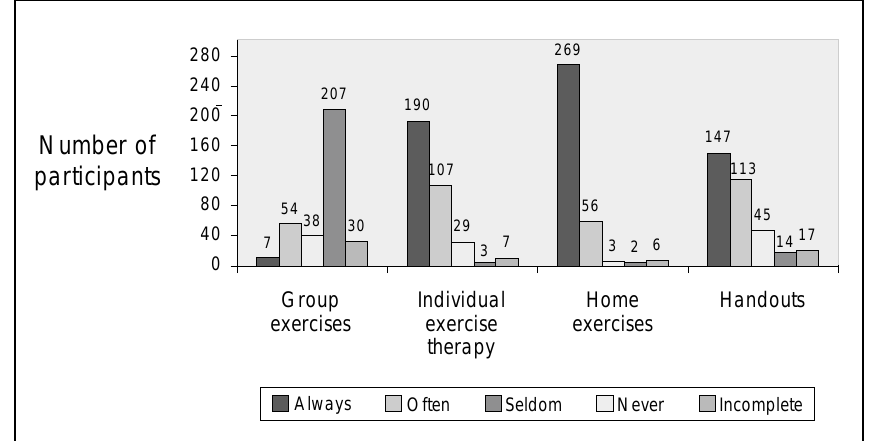
Figure 4: Application of exercise therapy.